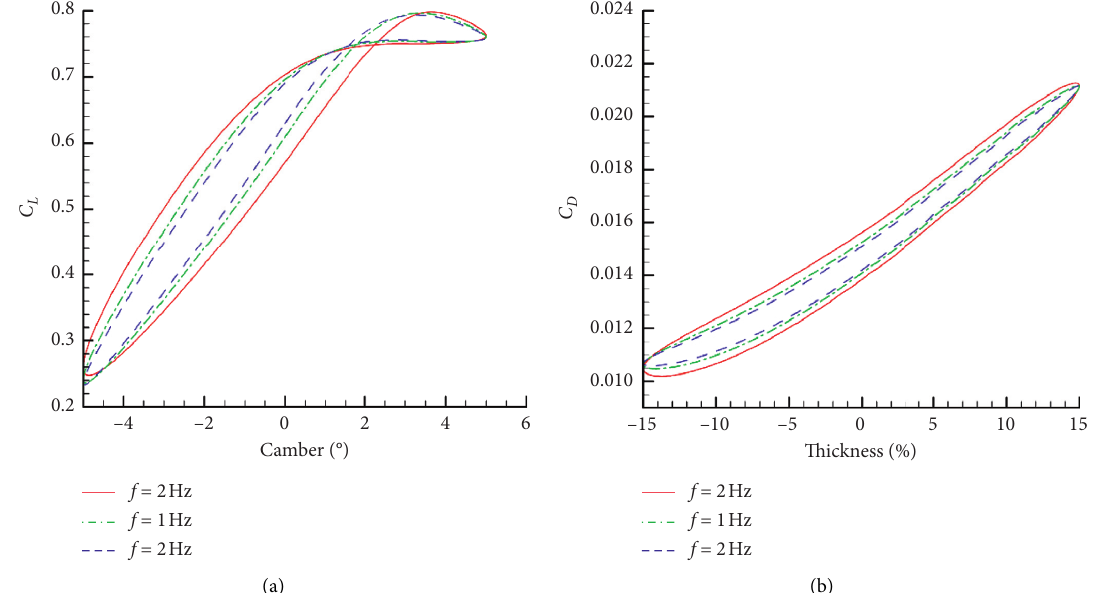
Figure 13: Influence of camber deformation frequency on aerodynamics ( M � 0.74 and α � 2 ° , CFD).